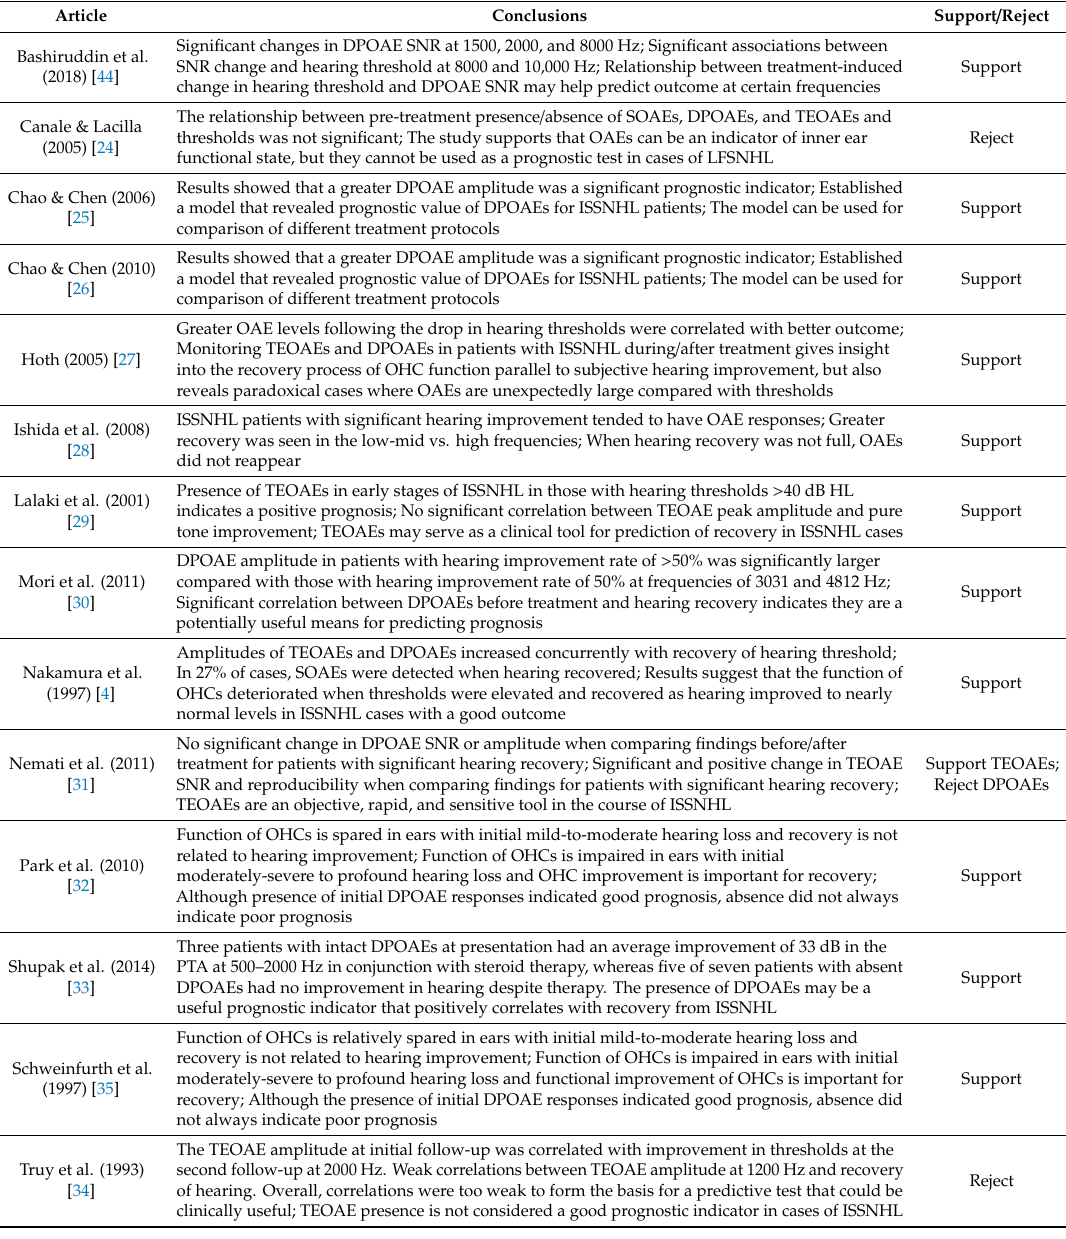
Table 4. Evidence of intervention benefit and support for use of OAE when monitoring auditory recovery. OHC, outer hair